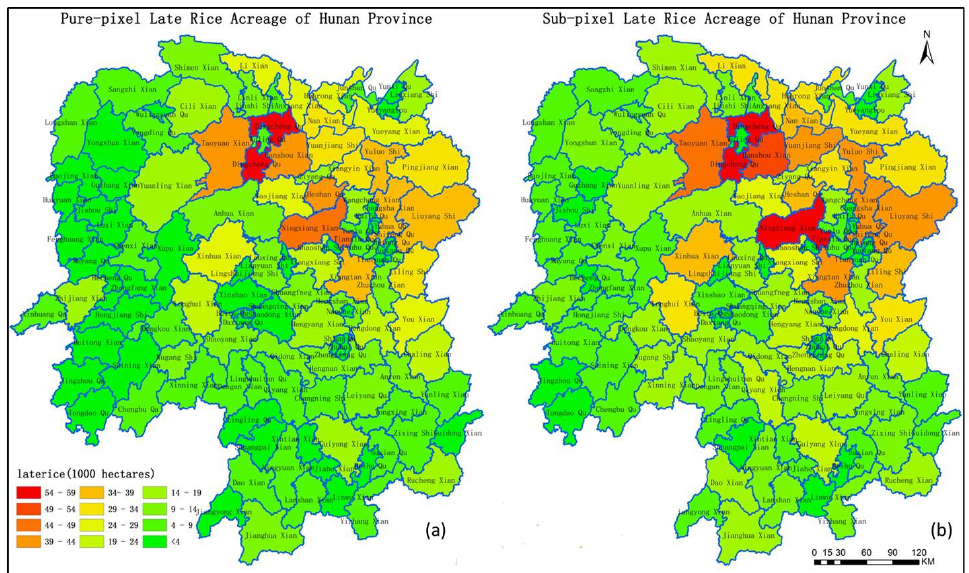
Figure 5. Pure-pixel, sub-pixel comparisons of late-season rice